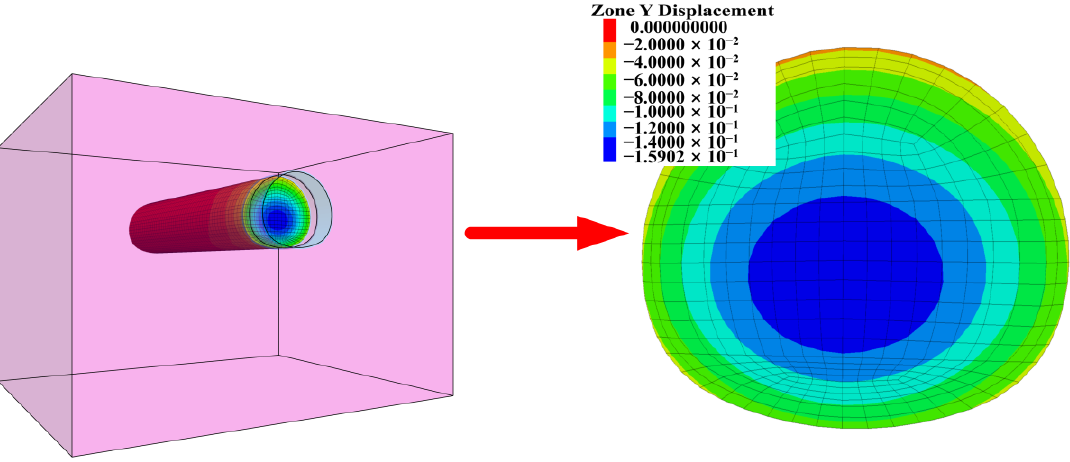
Figure 16. Extrusion displacement contour of tunnel face.